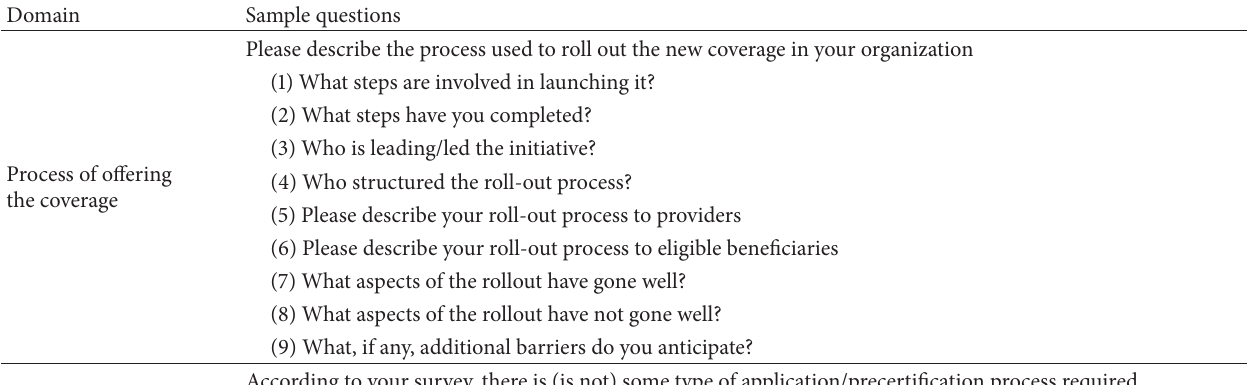
Table 1: Key informant interview domains with sample